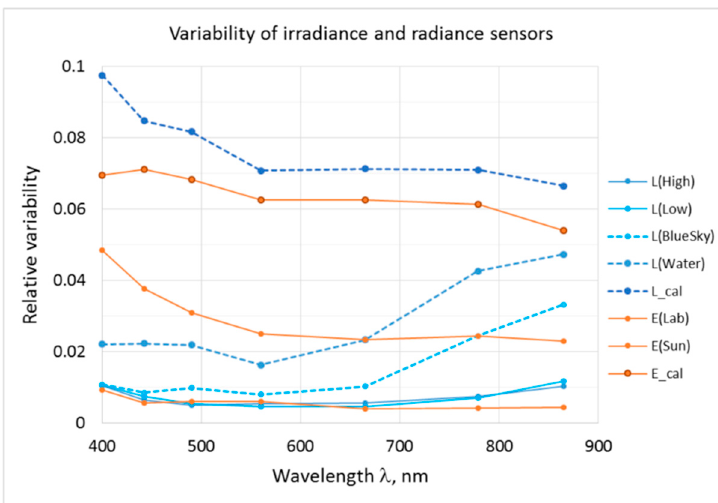
Figure 14. Variability between irradiance and radiance sensors. E _cal and L _cal—due to calibration state; E (Lab), L (Low) and L (High)—variability in laboratory intercomparison; E (Sun), L (BlueSky) and L (Water) variability in the field. Reproduced with permission from [46].